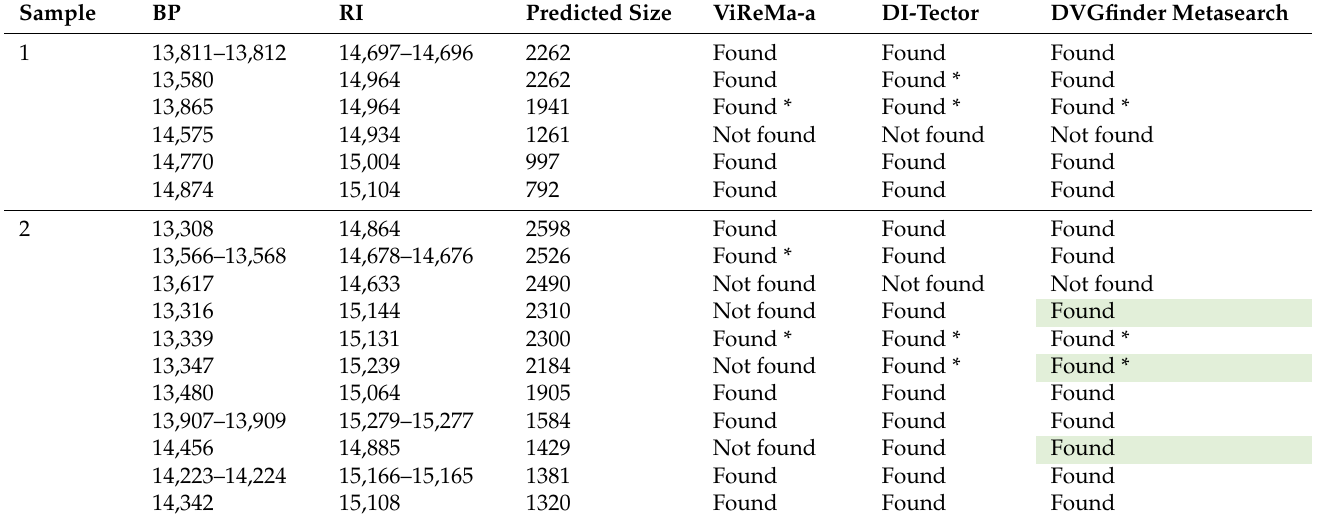
Table 7. 5 (cid:48) copy-back DVG genomes in mumps virus samples validated using RT-PCR [28] and its in silico detection. In green are highlighted the DVGs that were detected only by DI-tector. The (*) indicate the DVG was found with the deep assessment strategy explained in Section 2.9, although the coordinates may not match